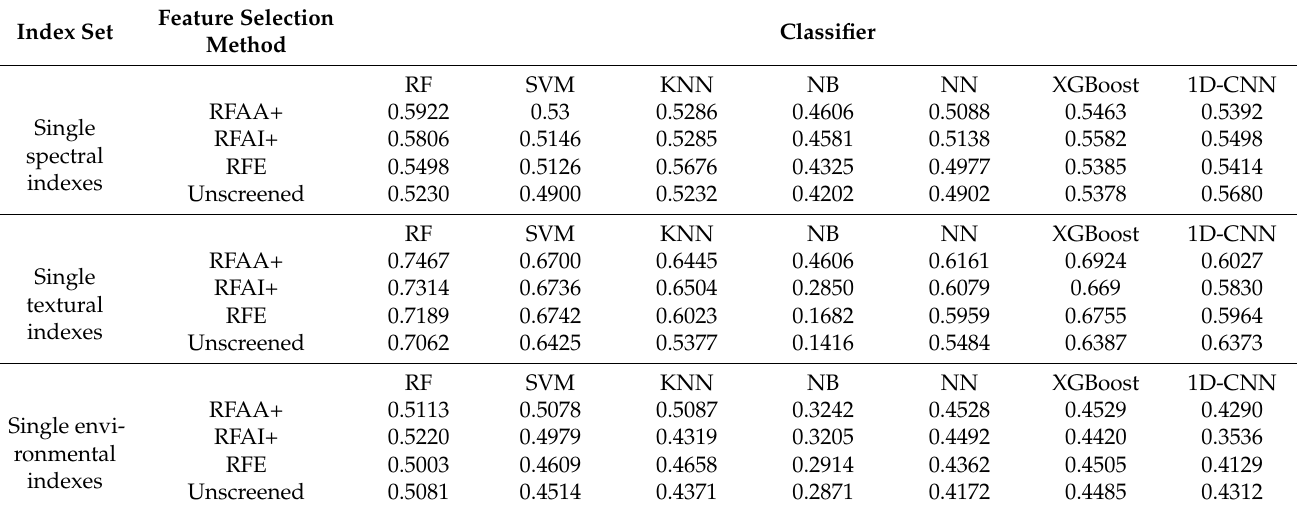
Table 6. The Kappa coefficients under the coupling analysis of different classifiers and FS